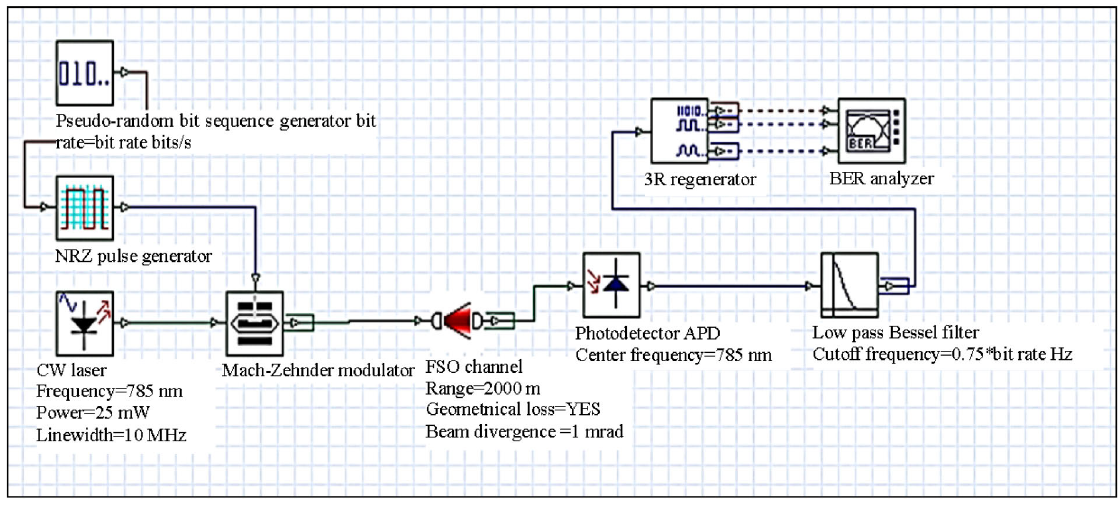
Fig. 1 One-channel FSO system components in “Optisystem ™